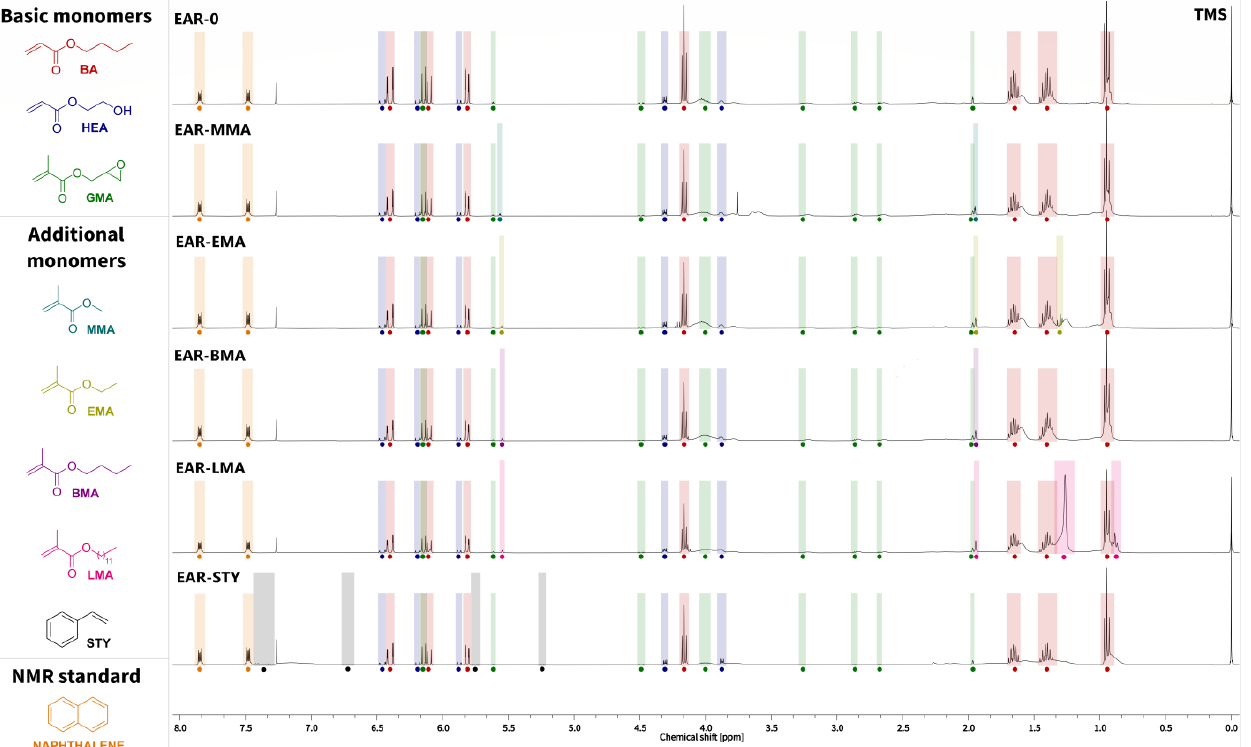
Table 4. Monomers’ conversion calculated by proton nuclear magnetic resonance ( 1 H NMR) anal- yses.